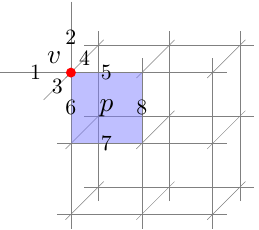
Figure 8. The local operators in the 3d toric code